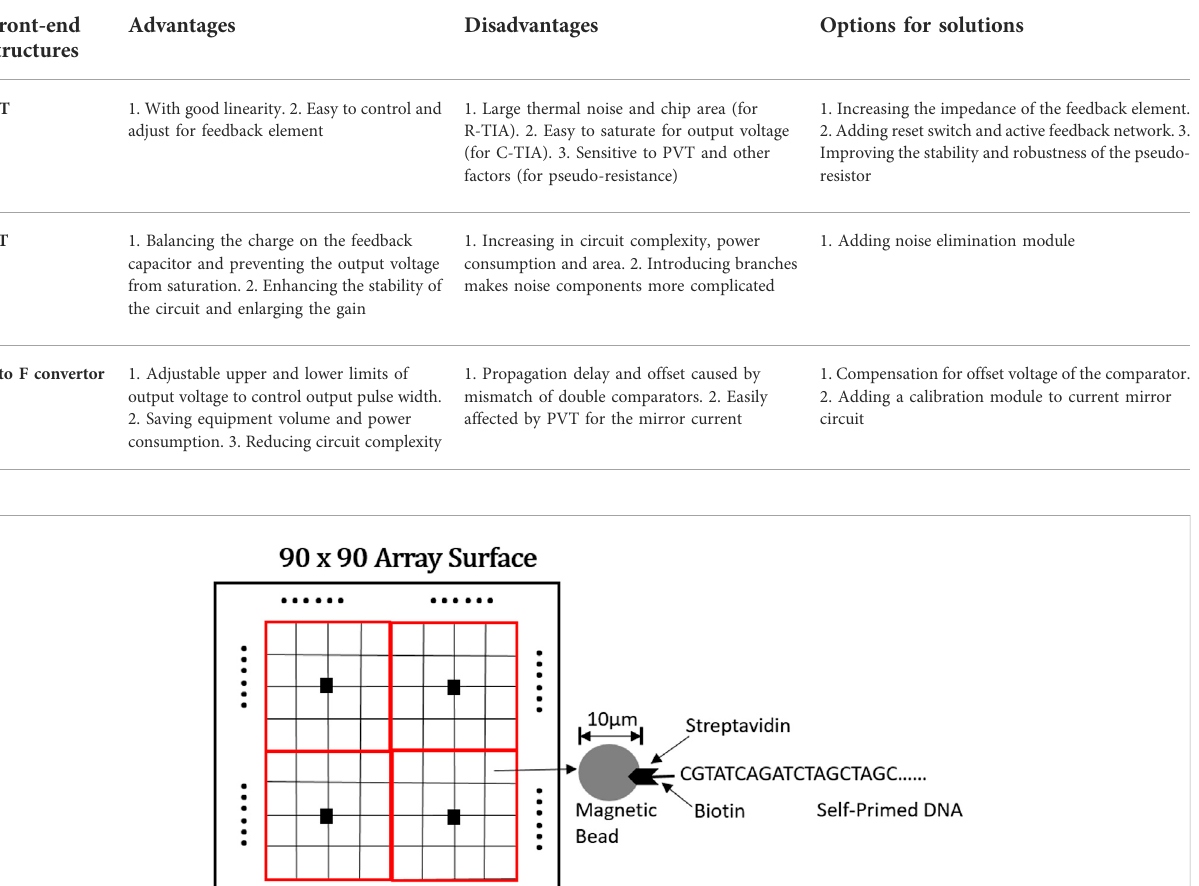
TABLE 5 Comparison of advantages and disadvantages of three current mode front-end structures. Front-end structures